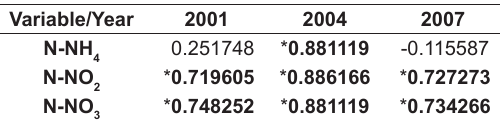
Table 2. Spearman´s nonparametric correlation among nitrogen nutrients and TSS during the three hydrological years (* significant at p< 0.05).